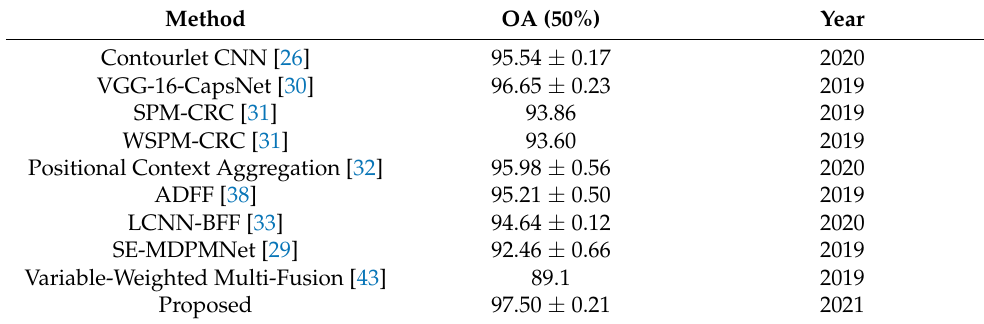
Table 6. OA (%) of seven kinds of methods and the LCNN-CMGF method under the training ratios of 50% in the RSSCN7